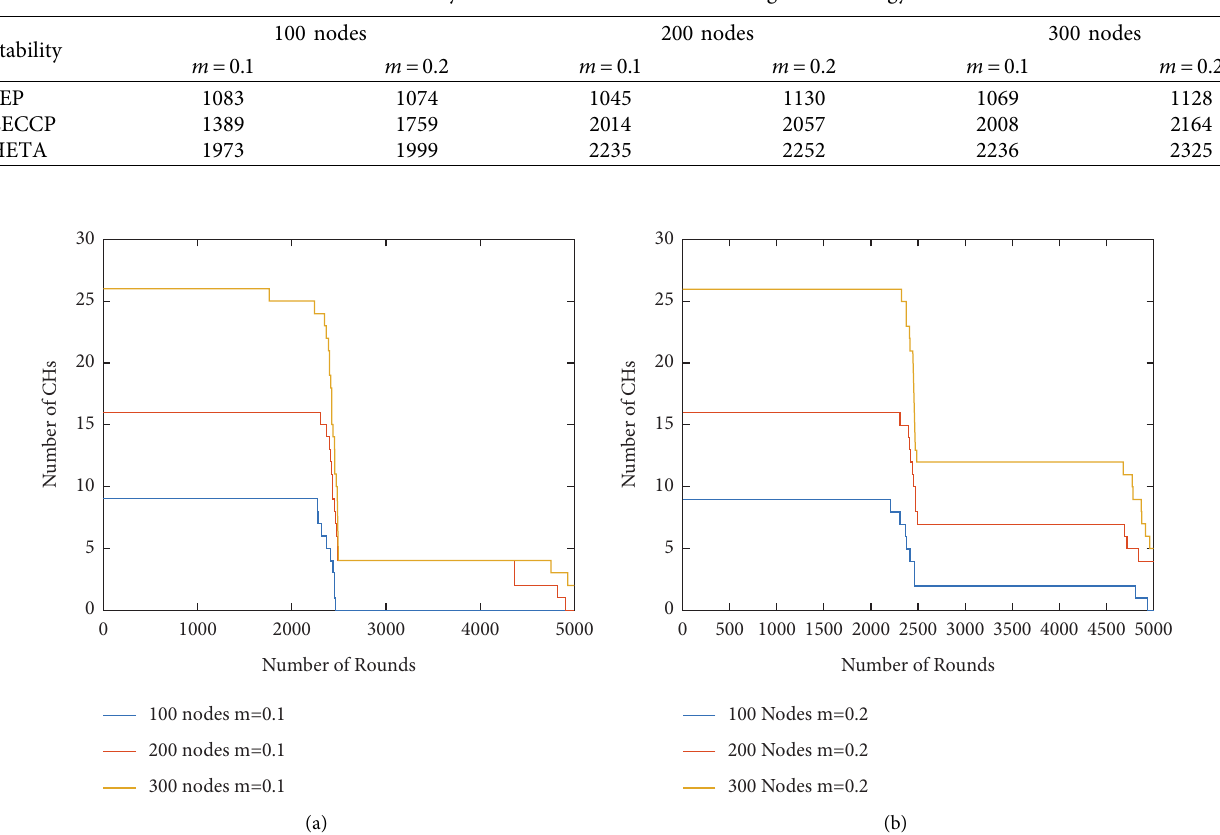
Figure 3: (a) Stability of the network with an increase in the number of nodes. (b) Characteristics of drain current with negative gate voltage. Table 2: Stability of the network in various heterogeneous